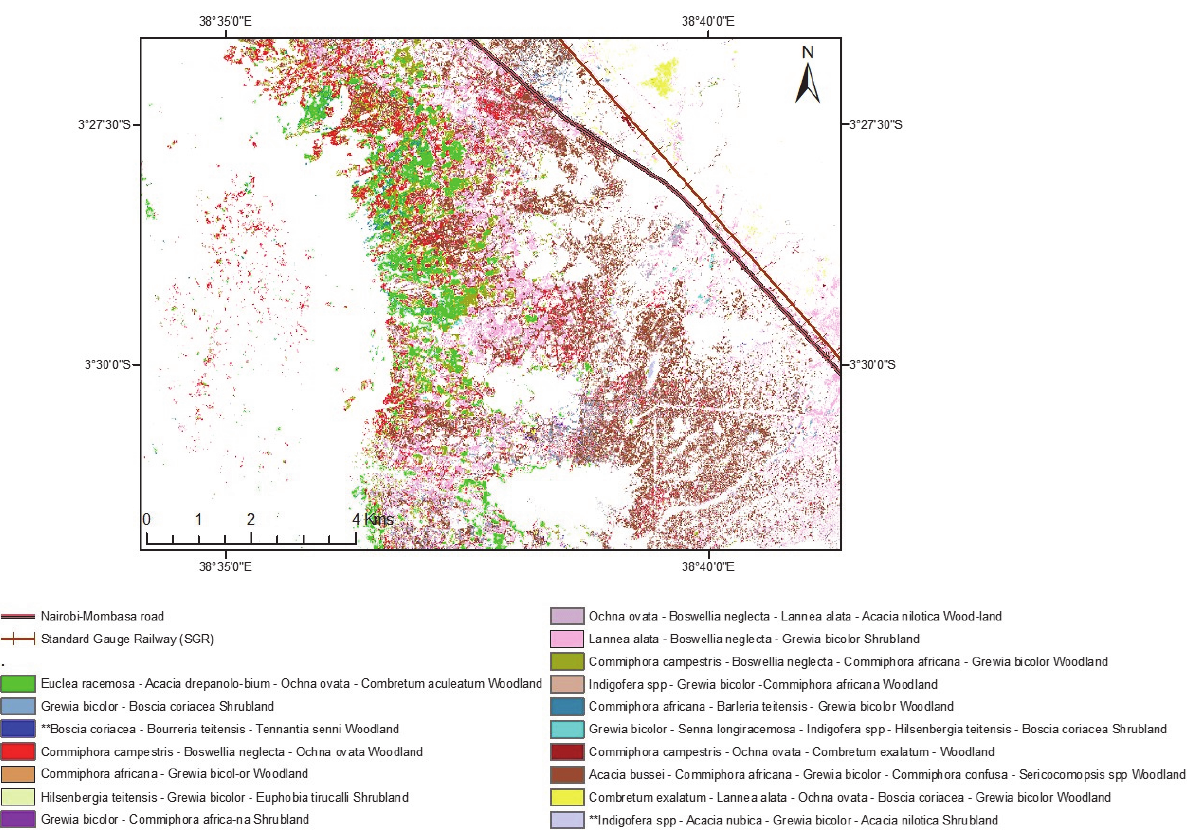
Figure 13. Output map showing classified vegetation communities named based on floristic dominance and associations. Those labelled starting with ** are the classes that would require additional field assessment as they had few sampling sites and species recorded introducing potential bias, to ascertain species dominance and types.